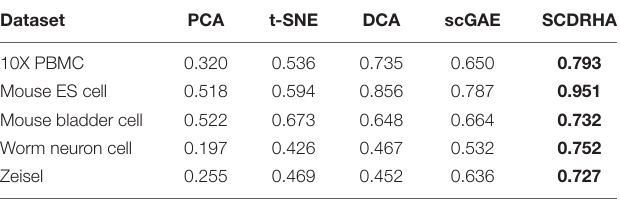
TABLE 3 | Normalized Mutual Information (NMI) score under different datasets.